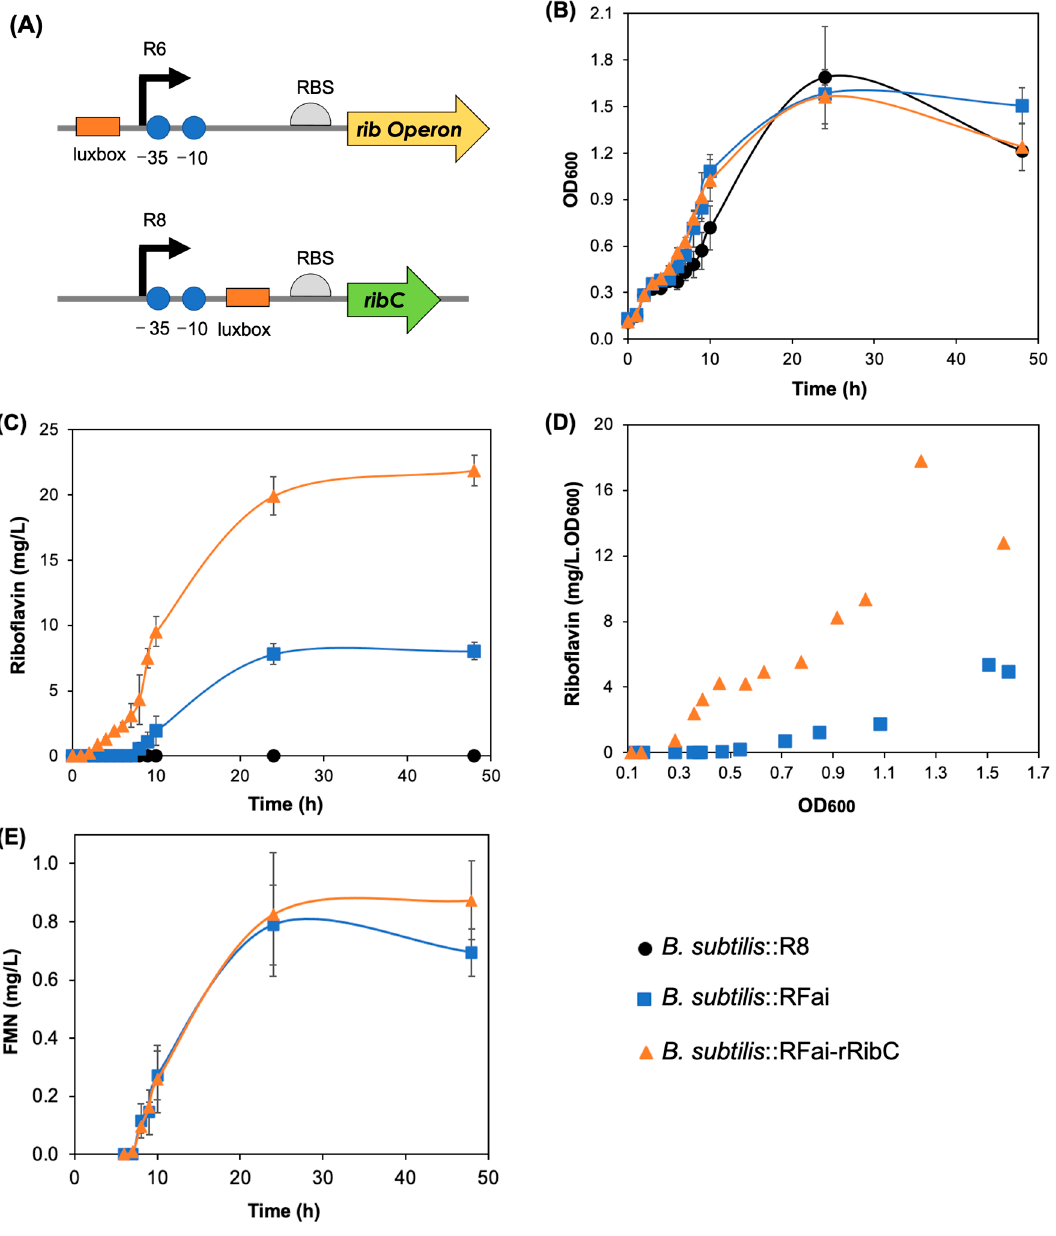
Figure 2. Engineered B. subtilis growth and riboflavin production. ( A ) R6 and R8 promoters were engineered to respond to AHL-Lux binding, generating opposite responses. In R6, binding occurs upstream to the − 35 region, causing transcription activation. In R8, binding occurs downstream to the − 10 region, causing transcription blockage. ( B ) All three engineered strains grew similarly, indicating that neither the autoinduction device nor the blockage of ribC expression impairs the population development. ( C ) Riboflavin production by the three engineered strains measured in the culture medium. ( D ) Correlation between the specific riboflavin production and the population density (OD 600 ). ( E ) FMN accumulation in the culture medium. Data are presented as mean ± SD (n = 3). Raw data is available in Supplementary Data